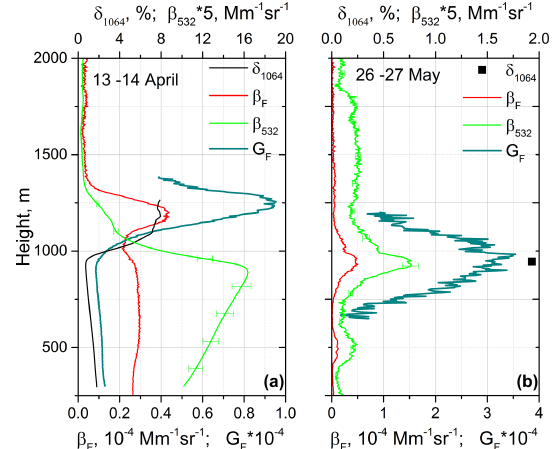
Figure 13. Vertical profiles of elastic β 532 and fluorescence β F backscattering coefficients, fluorescence capacity G F , and particle depolarization ratio δ 1064 measured on (a) 13–14 April at 21:00– 01:00UTC and (b) 26–27 May 2020 at 23:30–00:40UTC. Values of β 532 are multiplied by a factor of 5.